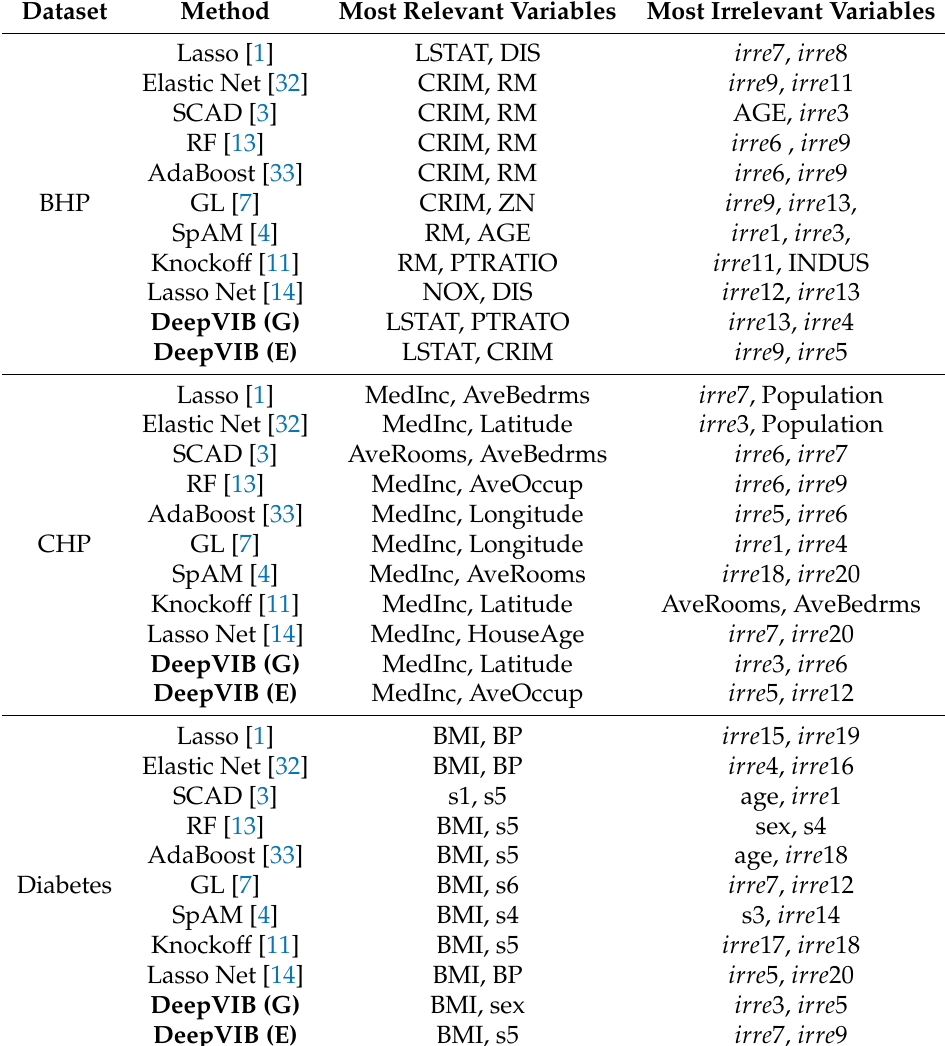
Table 5. Variable selection results on real